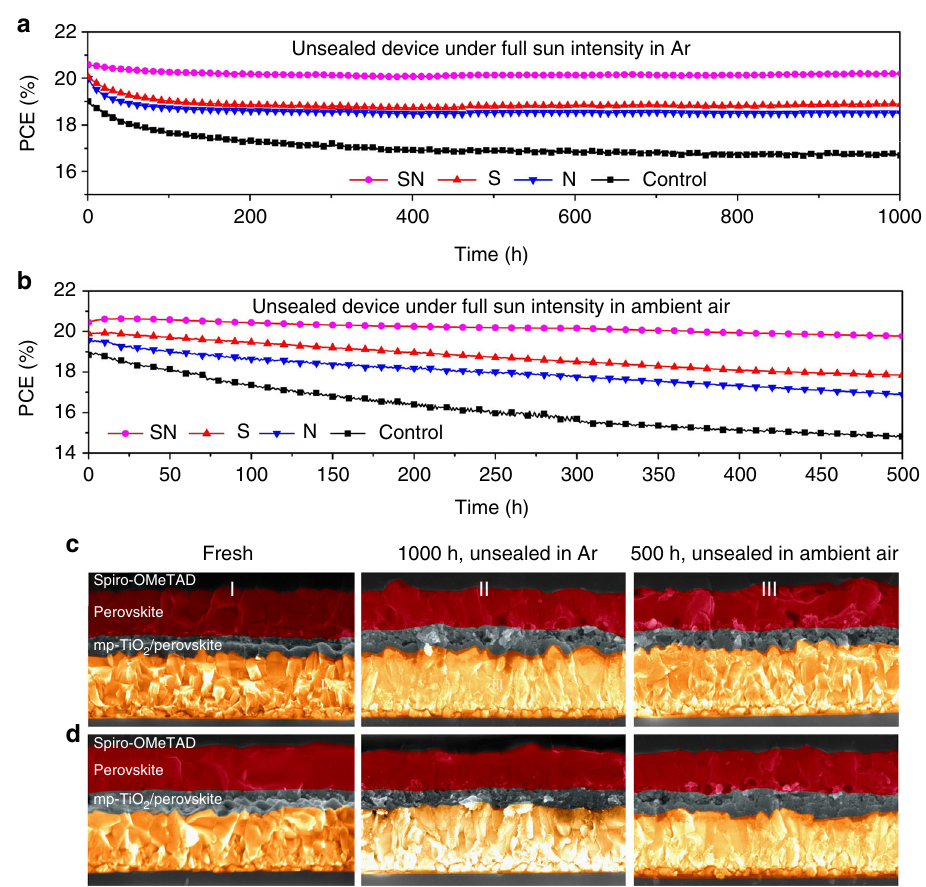
Fig. 5 Stability study. Evolution of the PCE over time measured by maximum power point tracking of unsealed PSCs of aperture area of 0.16 cm 2 under light soaking with full solar intensity at temperature between 55 and 60 °C. Cells were kept under a Ar atmosphere and b ambient air at approximately 20% humidity. PV metrics are summarized in Supplementary Tables 7 – 10. Cross-sectional SEM images of the c pristine and d SN-modulated perovskite fi lms in completed PSC devices before (I) and after aging under light soaking with full solar intensity at temperature between 55 and 60 °C in Ar over 1000h (II) and ambient air at ~20% humidity over 500 h